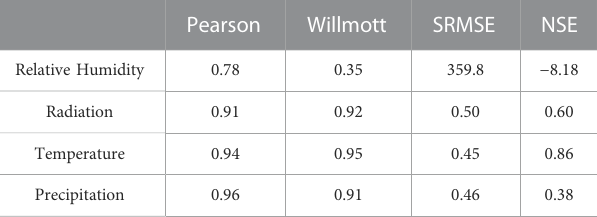
TABLE 3 Statistics indices for